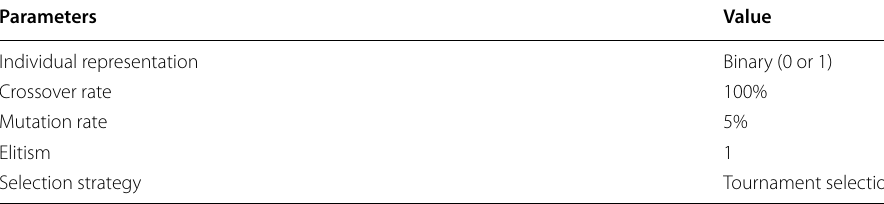
Table 6 The GA parameters